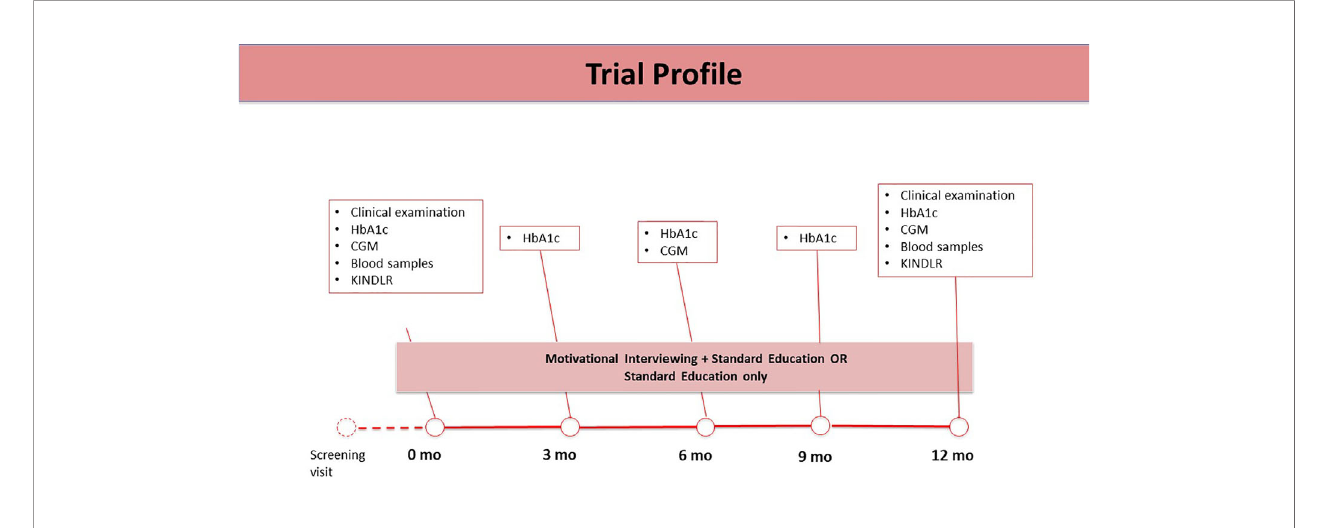
FIGURE 2 | Trial Pro fi le.